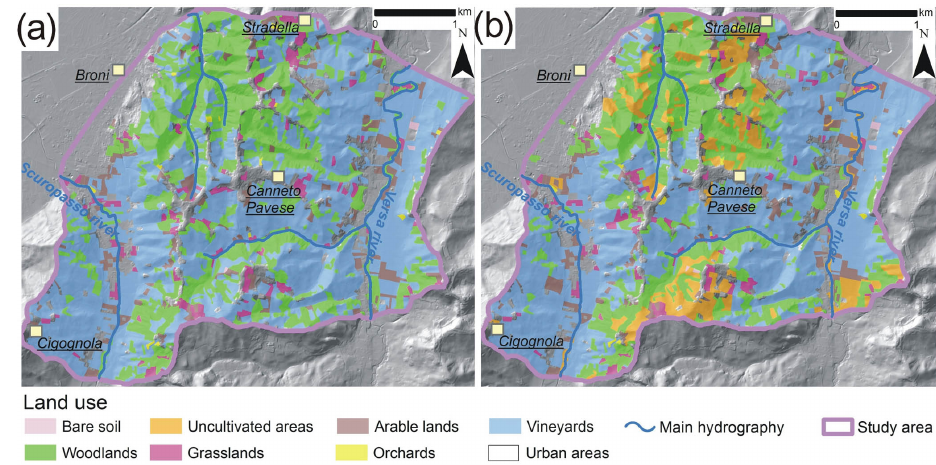
Figure 5. Potential land use scenarios used for the assessment of road susceptibility to shallow landslides in the study area, together with the 1980 land use distribution (Fig. 2c): (a) Scenario 3, correspondent to the transformation of actual uncultivated areas in woodlands; (b) Scenario 4, correspondent to an increase in abandoned areas similar to those in 1980–2015